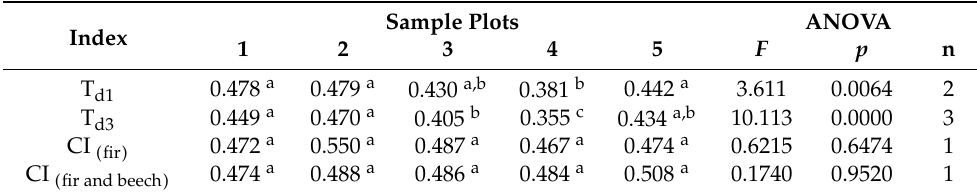
Table 4. Analysis of variance—the diameter differentiation index and the Weber height competition index.